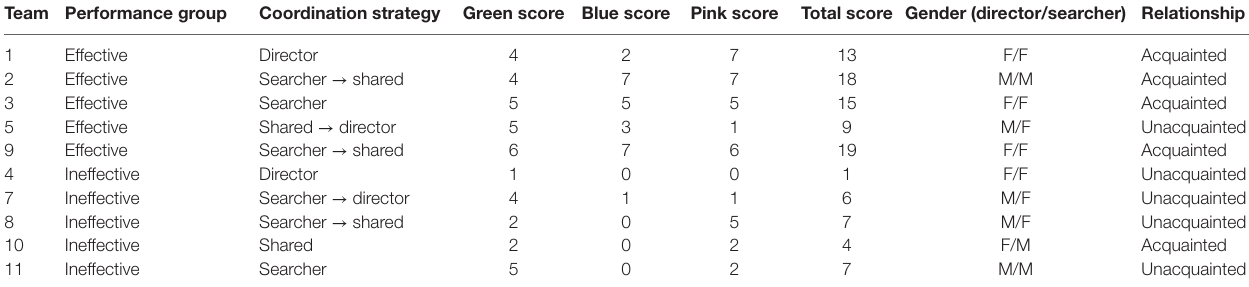
TaBle 3 | Team and participant composition. Team Performance